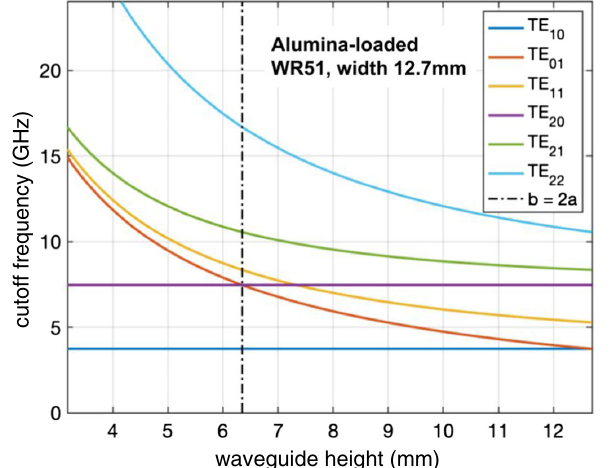
FIG. 17. Cutoff frequencies for alumina-loaded waveguides of 12.7-mm width and variable height.